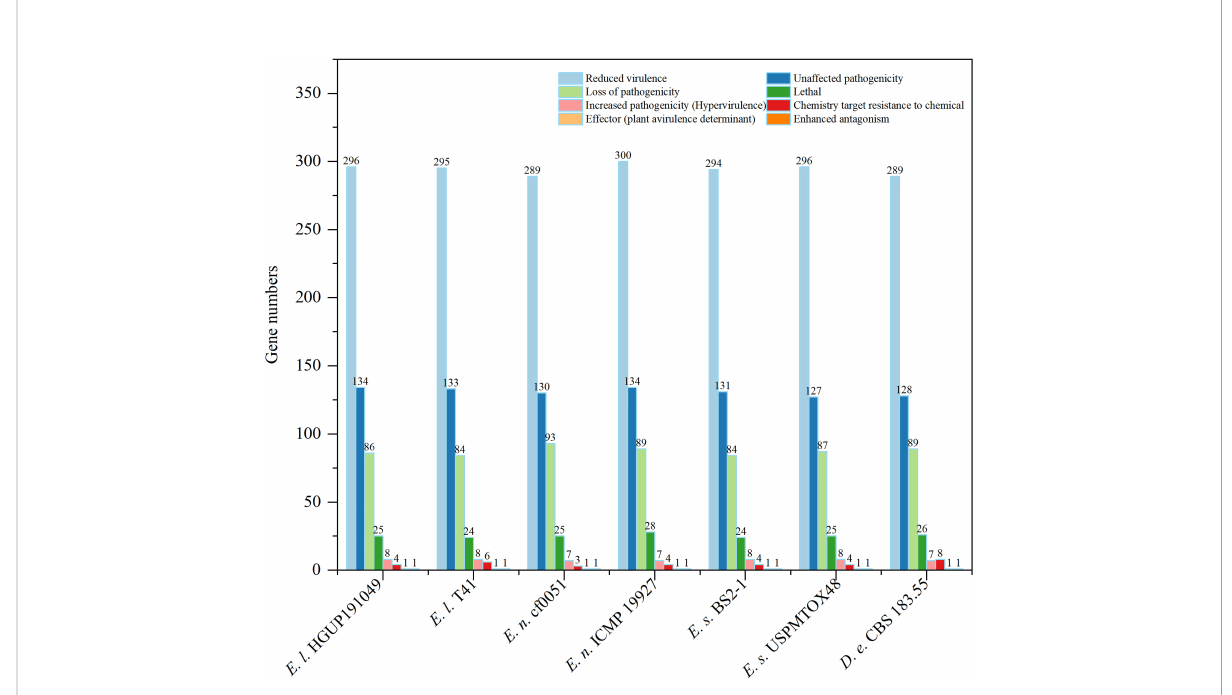
FIGURE 8 Comparisons and annotations of pathogen-host interactions (PHI). D.e , Didymella exigua ; E.l , Epicoccum latusicollum ; E.n , Epicoccum nigrum ; E.s , Epicoccum